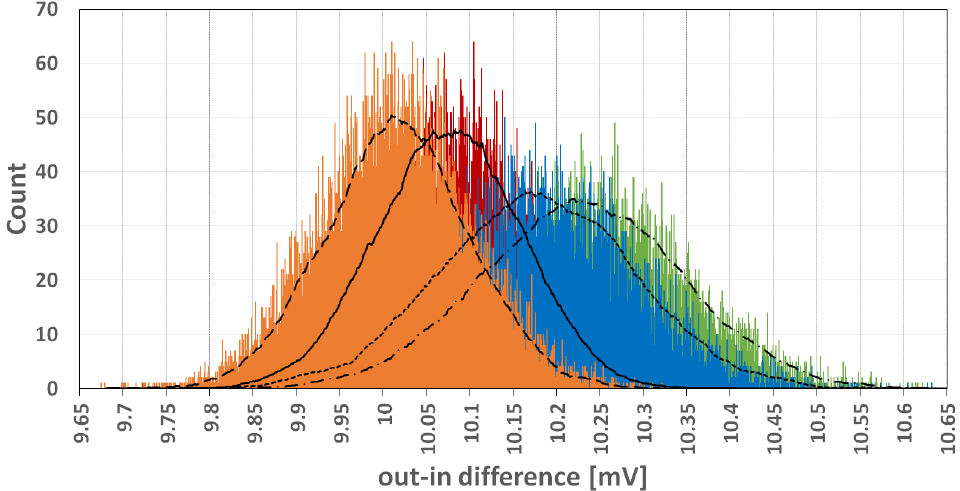
Figure 19. Readout distributions for all the scrutinized variants of the buffer with their envelopes; the original buffer—blue and dotted line; the SOAC buffer—green and dashed-dotted line; the laid-out original buffer—orange and dashed line; the laid-out SOAC buffer—red and solid line.